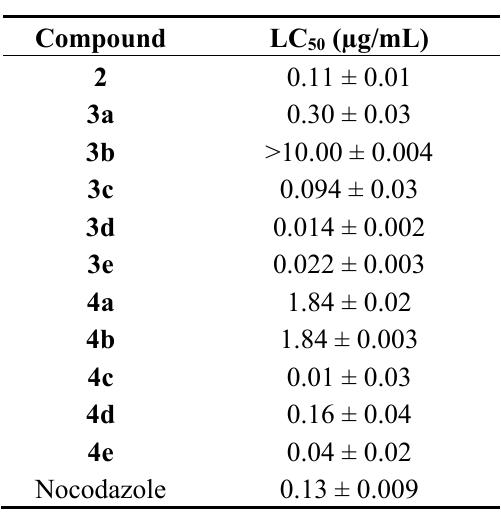
Table 1. Cytotoxic effects of polycarbo-substituted alkyl (thieno[3,2- c